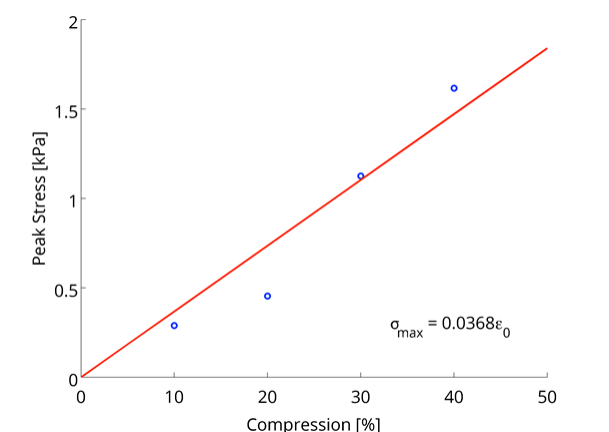
Fig. 7. Peak stress ( σ max ) as a function of initial compression. The relationship was found to be approximately linear and was fit via linear regression ( R 2 = 0.91). Given the assumptions of the chosen model, this result is in line with what was expected.